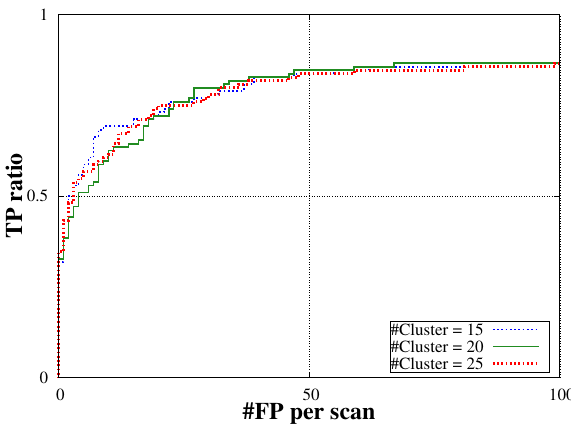
Figure 13. FROC curves of individual cluster numbers for training in FP